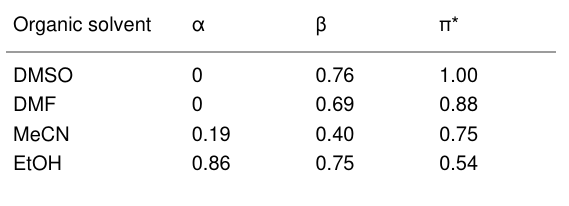
Table 2: The Kamlet–Taft solvent parameters of the organic solvents used in this study [58]. Organic solvent